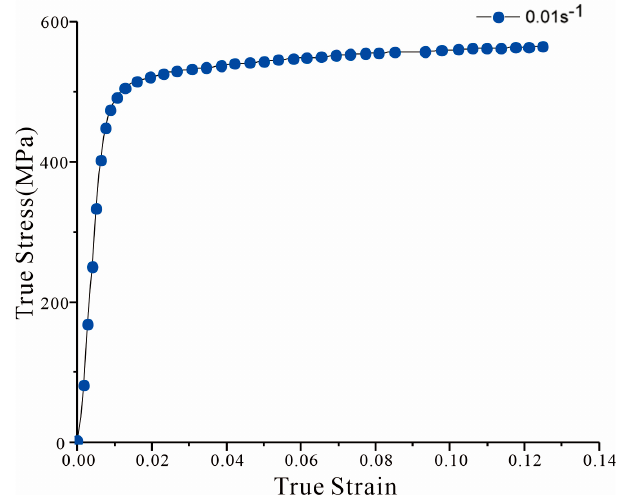
Figure 4. Stress-strain curve of Al7075-T6 at quasi-static strain rate.